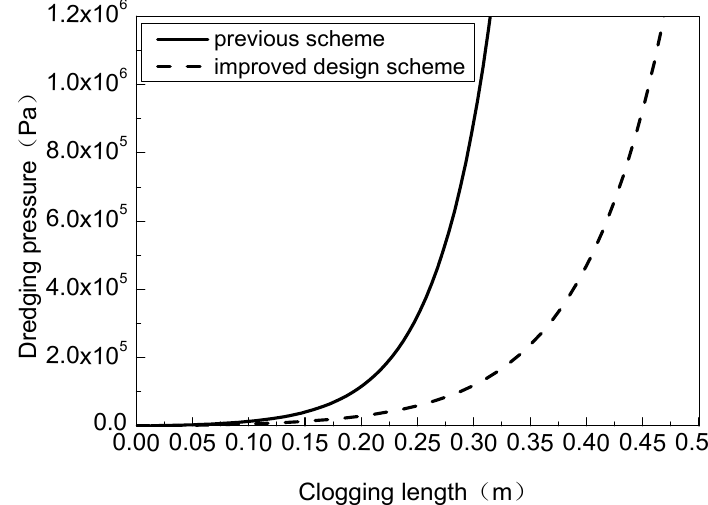
Figure 11. Comparison of the p – L characteristic curves between the improved design and the previous scheme.